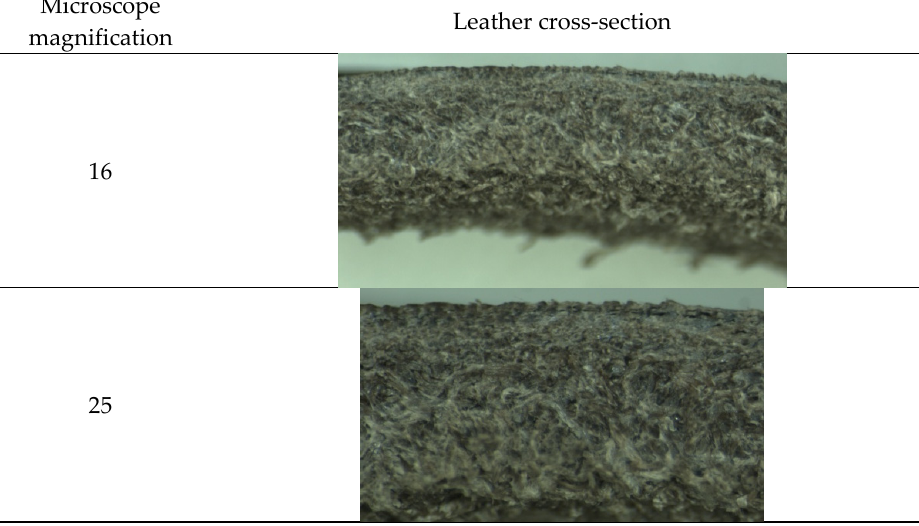
Figure 7. Leather cross-section.